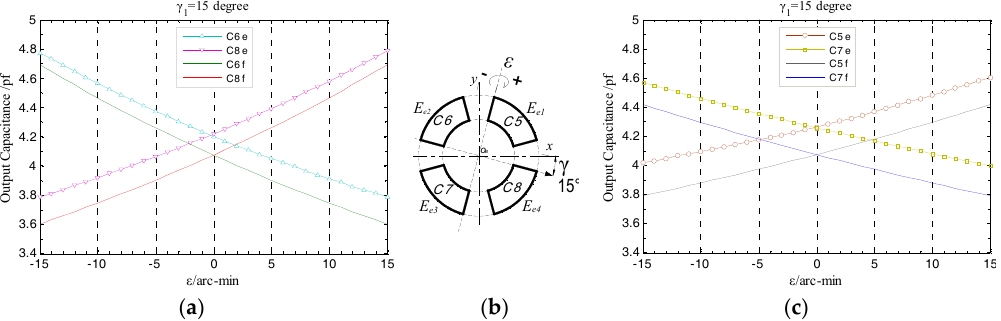
Figure 26. Comparison of experimental and simulation values of the end part fan-shaped electrode output capacitance: ( a ) Comparison between the second and fourth quadrants; ( b ) tilt schematic; ( c ) comparison between the first and third quadrants.